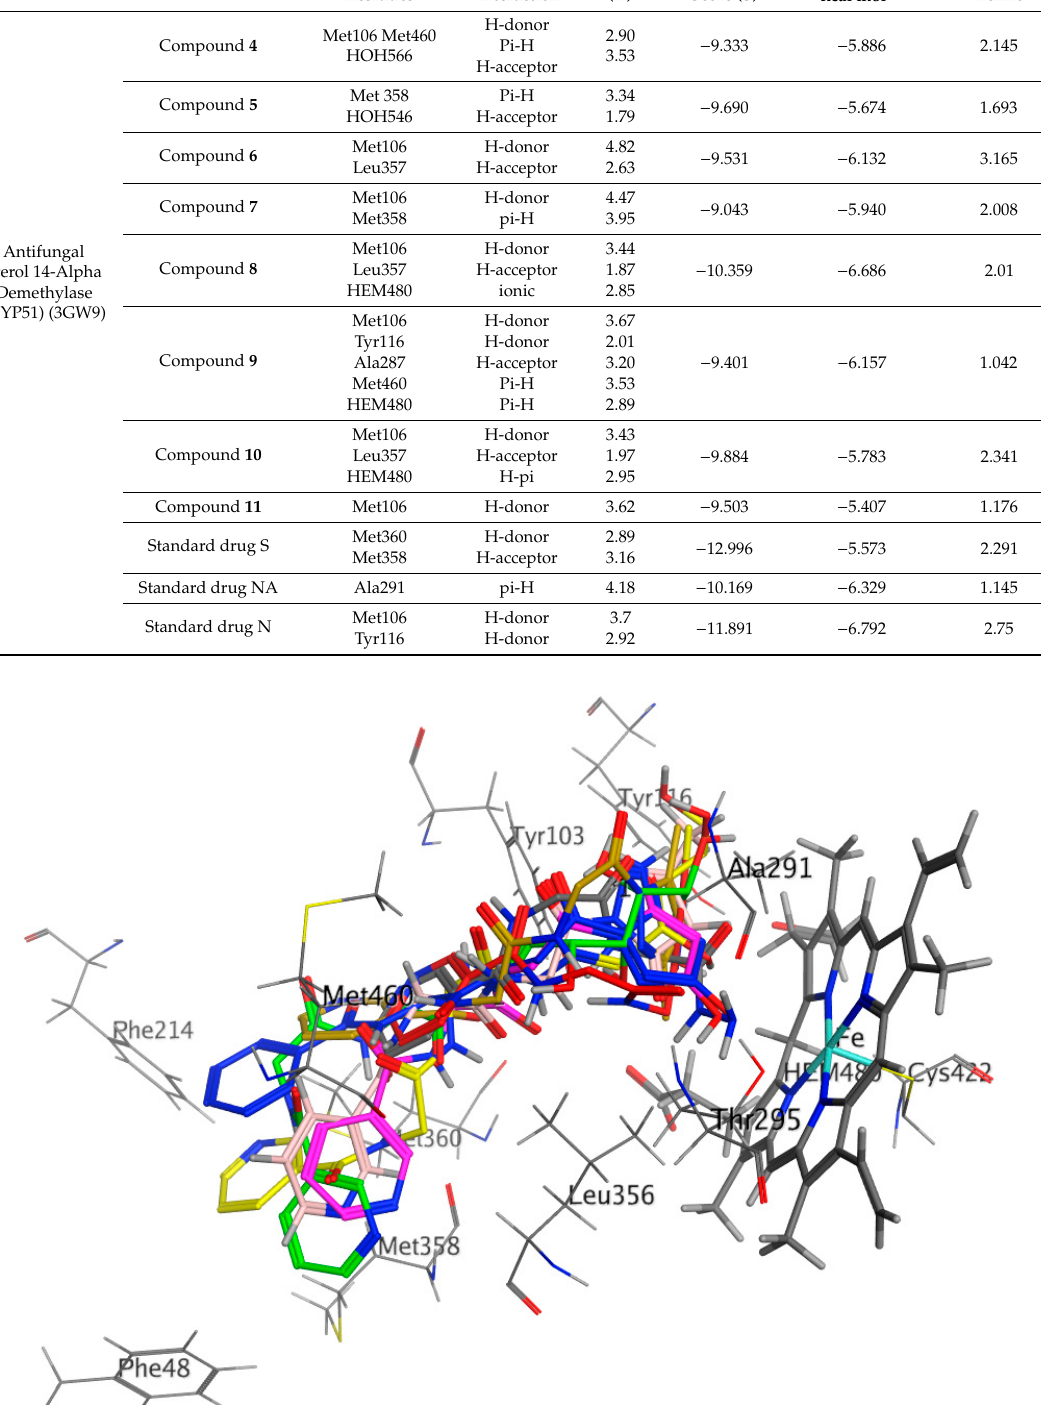
Figure 2. Compounds 4 to 11 superimposed by their poses of non-covalent docking in the active site of CYP51 pocket.